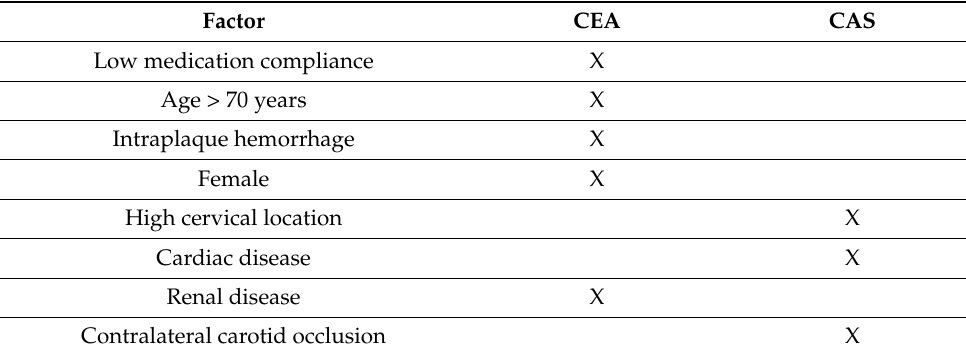
Table 2. Individual patient factors favoring CEA versus